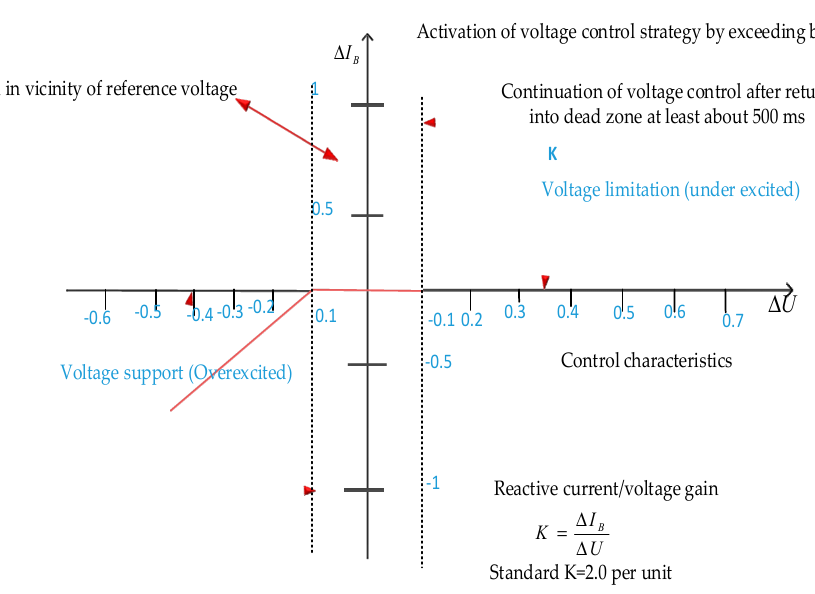
Figure 11. Dynamic voltage regulation for wind turbines based on Figure 11 .Dynamic voltage regulation for wind turbines based on DFIG.